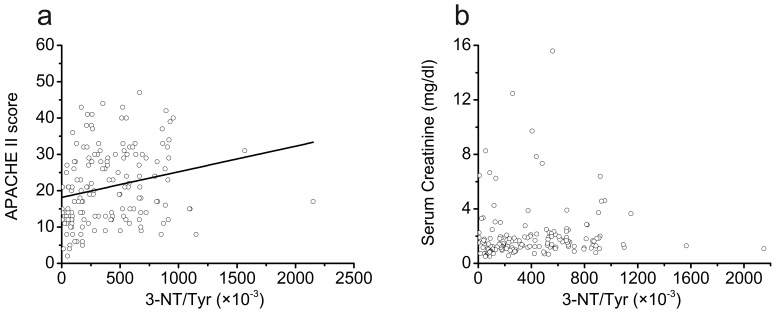
Correlations analysis of 3-NT/Tyr with APACHE II score and serum creatinine as AKI diagnosed in 158 patients with AKI.(a) correlation between 3-nitrotyrosine to tyrosine and APACHE II score, adjusted r2 = 0.048, p = 0.003. (b) correlation between 3-nitrotyrosine to tyrosine and serum creatinine as AKI diagnosed, p = 0.544. APACHE II, Acute Physiology and Chronic Health Evaluation II.